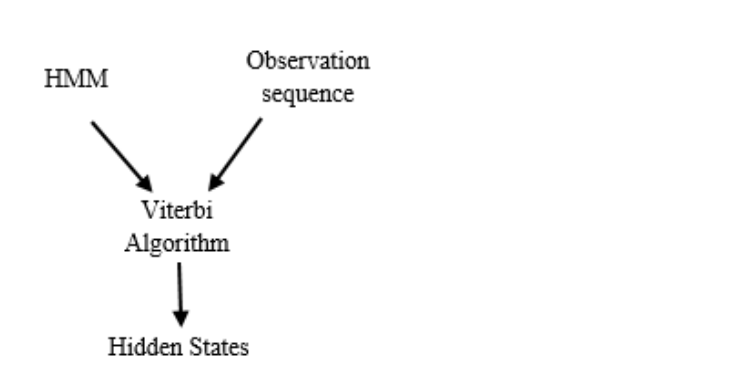
Figure 21. Schematic of hidden Markov model (HMM), Viterbi algorithm, observations and states.